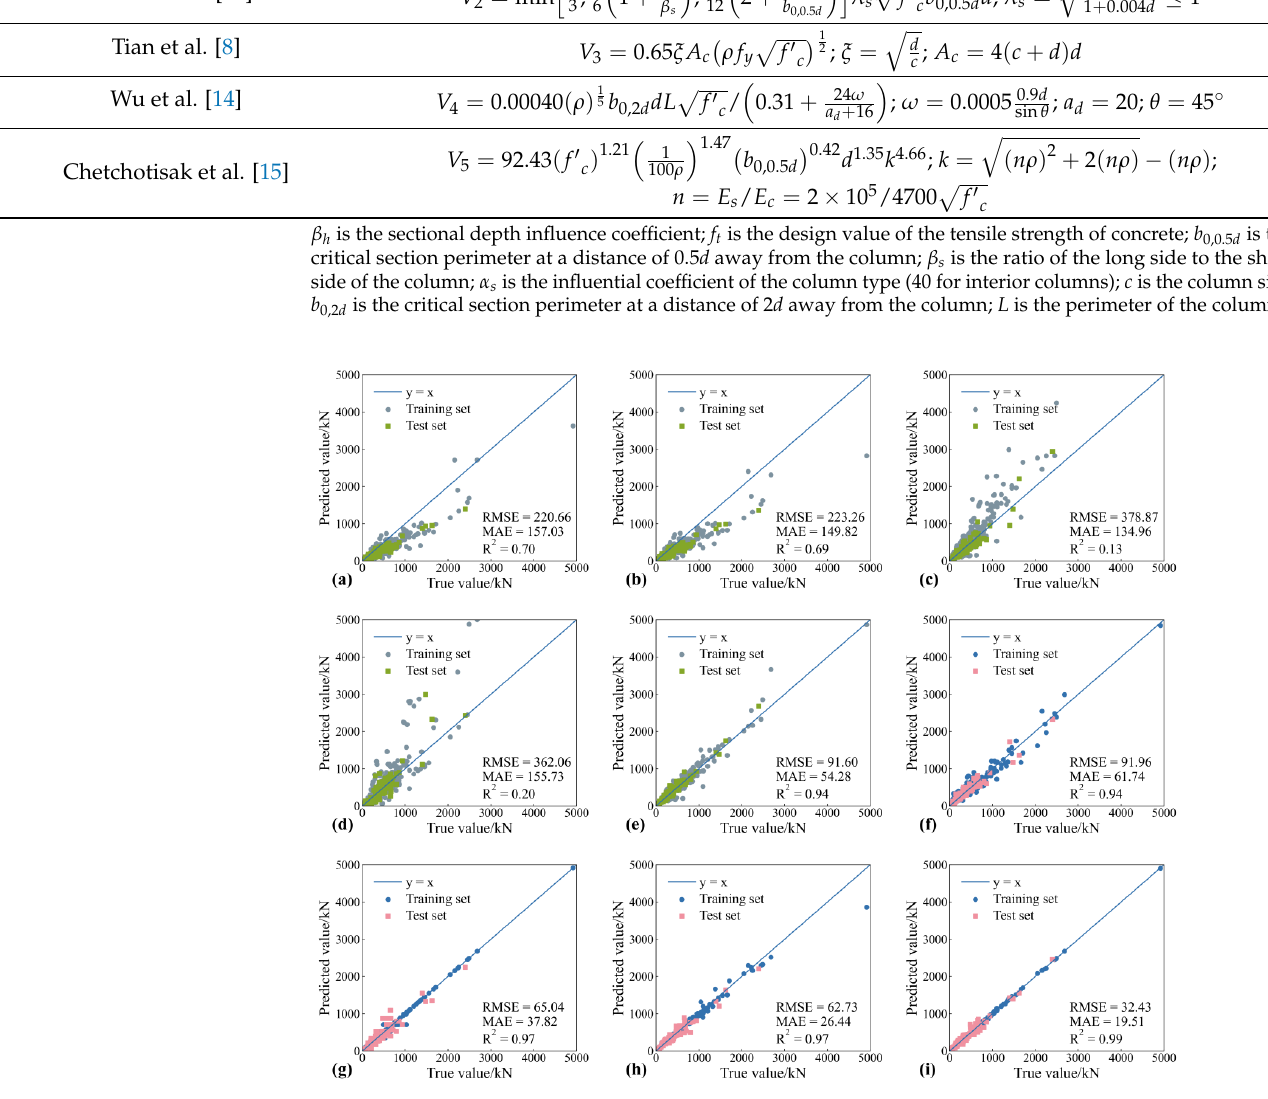
Figure 5. Scatter plots of the prediction results of the empirical models and the ML models: ( a ) GB 50010-2010; ( b ) ACI 318-19; ( c ) Tian et al.; ( d ) Wu et al.; ( e ) Chetchotisak et al.; ( f ) ANN; ( g ) DT; ( h ) RF; ( i ) XGBoost.